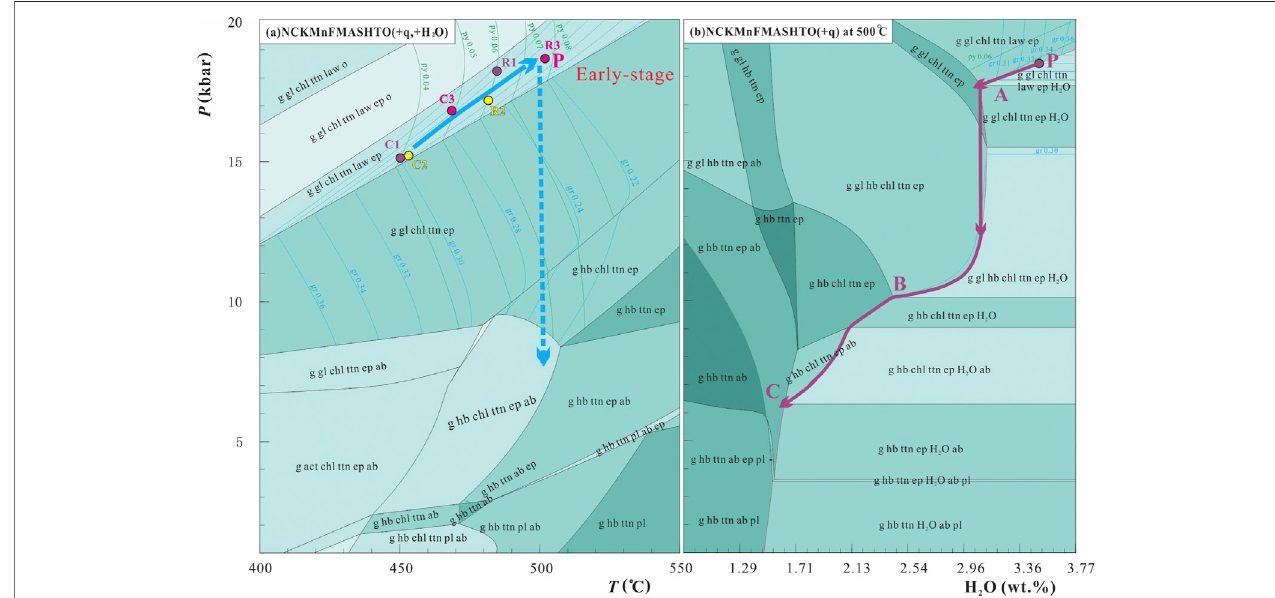
FIGURE8|(A) P – T pseudosectionforsampleEL08calculatedinthesystemNCKMnFMASHTO(+q,H 2 O)usingthemodi fi edbulk-rockcompositionfrom Table1 and (B) P – M (H 2 O) pseudosection calculated at temperature of 500 ° C. The pseudosection is contoured with isopleths of pyrope (py) and grossular (gr) in garnet. The plots of the measured pyropeand grossular in the core and rim of different garnet grains (g01, g02, and g03) are shown as different shapes marked with C (C1, C2, and C3). It is noted that the subtypes of amphibole used in pseudosections follow those in Diener et al. (2007) where glaucophane (gl) refers to sodic amphibole, actinolite (act) refers to calcic amphibole and hornblende (hb) refers to sodic-calcic amphibole or calcic amphibole. Others are the same as in Figures 4 , 7 .